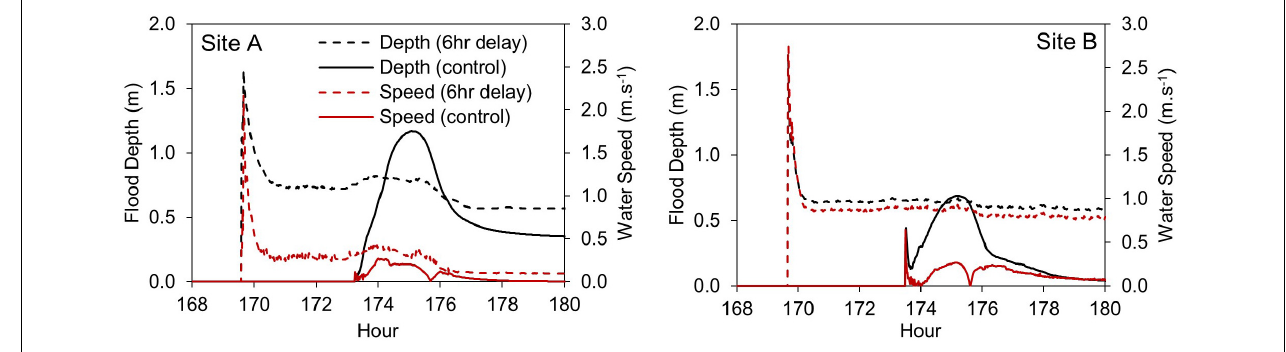
FIGURE 11 | Time series of floodwater depth and speed at (A) site A and (B) site B located in western part of Manhattan (see Figure 3 for the site locations).